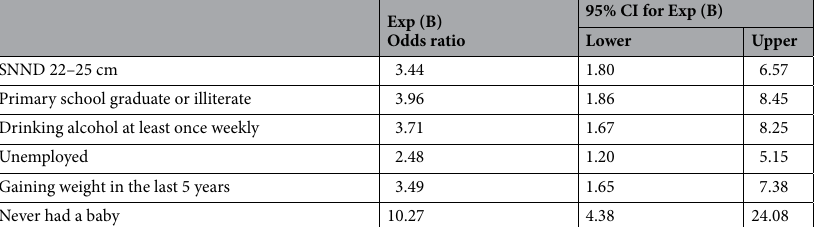
Table 6. Logistic regression model of risk factors (non-periodic mastalgia)—backward method results. Pseudo (Nagelkerke) R 2 = 0.465, Hosmer–Lemeshow χ 2 = 21.484, p = 0.006 (Step 7). Dependent variable: 1: mastalgia absent; 0: mastalgia present. CI confidence interval, OR odds ratio, SNND distance from the sternal notch to the